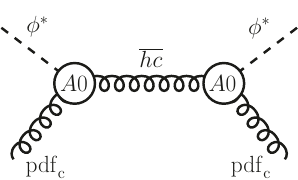
Figure 3 . Diagrammatic SCET representation of LP resummation. The Wilson lines attached to SCET operators are set to 1 in this